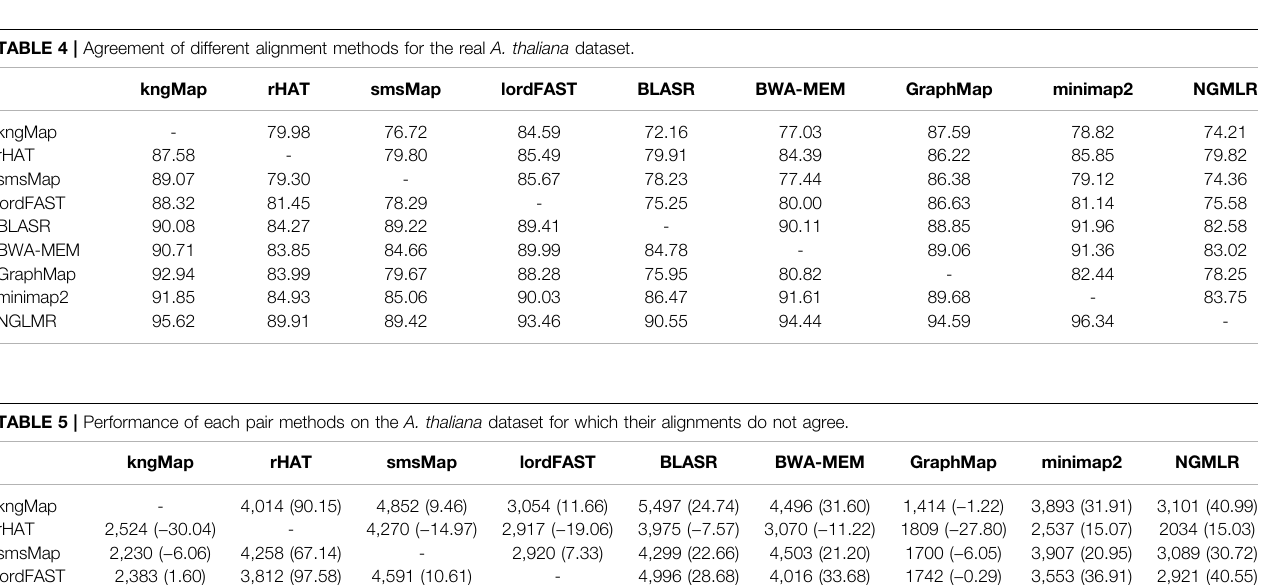
TABLE 4 | Agreement of different alignment methods for the real A. thaliana dataset. kngMap rHAT